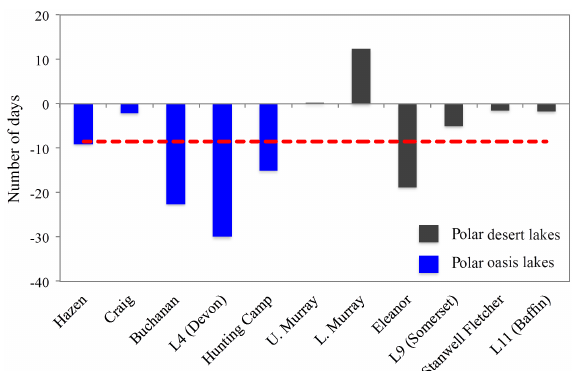
Figure 5. Changes – shown as number of days – in the summer ice minimum date of investigated lakes in the central and eastern Canadian High Arctic (1997–2011). Number of days change is re- ported relative to the 1997–2011 mean summer ice minimum day derived from spaceborne observations during this period. Lakes in polar-oasis environments are shown as blue bars and lakes in polar- desert environments are shown as grey bars. The red line indicates the 1997–2011 mean number of days change for summer ice mini-